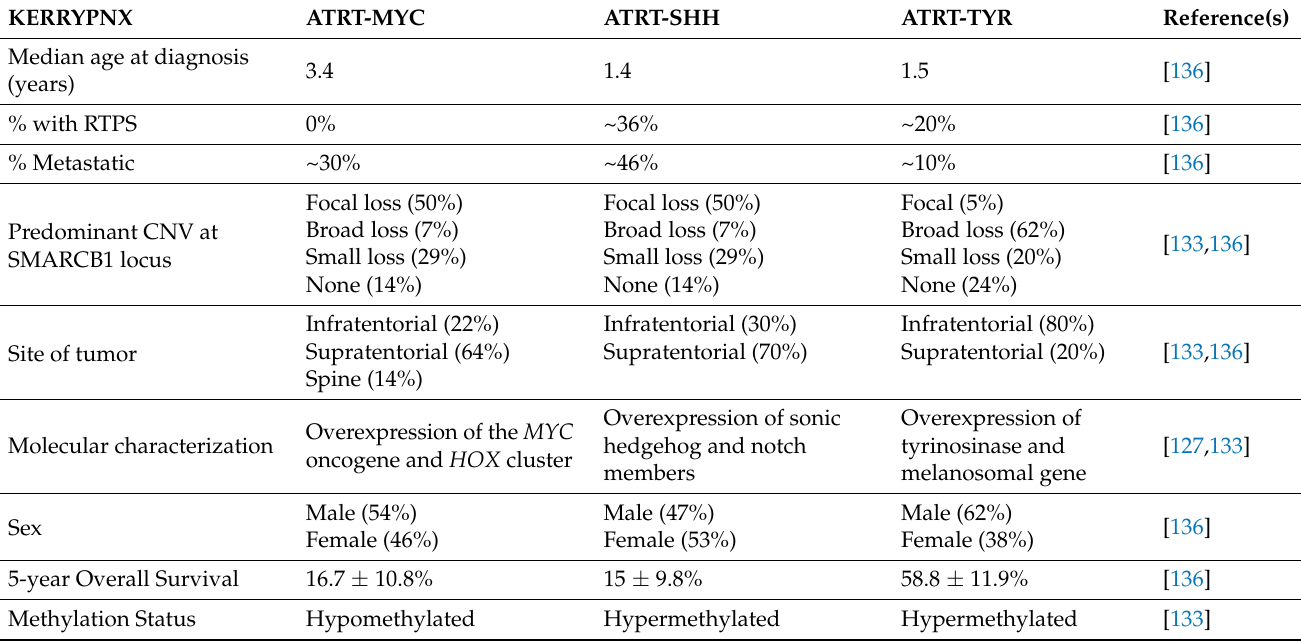
Table 1. ATRT subtypes and their respective clinical and molecular